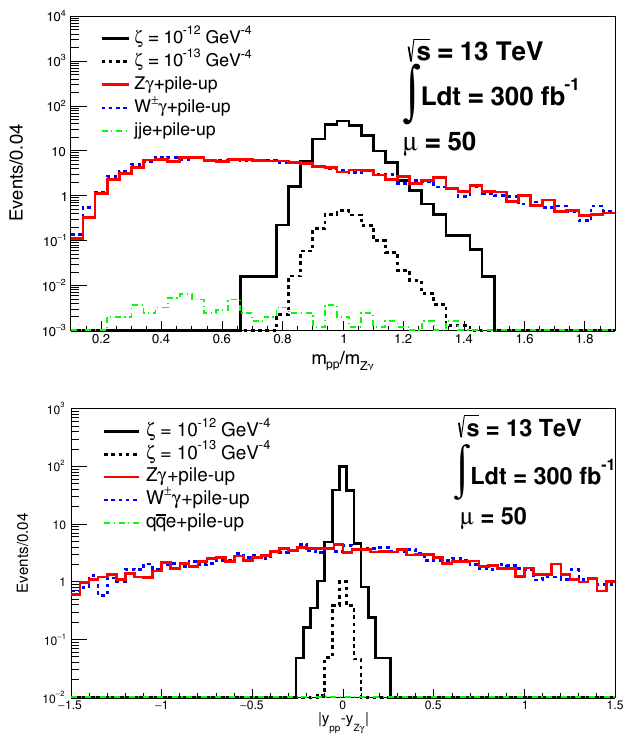
p Figure 5 . Missing diproton mass m pp = (cid:24) 1 (cid:24) 2 s to central mass ratio distribution (top) and rapidity di(cid:11)erence distribution (bottom) in the jj(cid:13) channel for the signal and background within the acceptance 0 : 015 < (cid:24) 1 ; 2 < 0 : 15 considering two di(cid:11)erent coupling values after applying the requirement on p T , invariant mass m Z(cid:13) , p T ratios and angle separation according to table 1. The integrated luminosity is 300 fb (cid:0) 1 and the average pile-up is (cid:22) = 50. The signal width is due to a combined e(cid:11)ect of the reconstructed jet energy low resolution ( (cid:25) 15%) and the (cid:24) 1 ; 2 resolution from the proton detectors. The asymmetry on the m pp =m Z(cid:13) distribution is due to the resolution on the jet